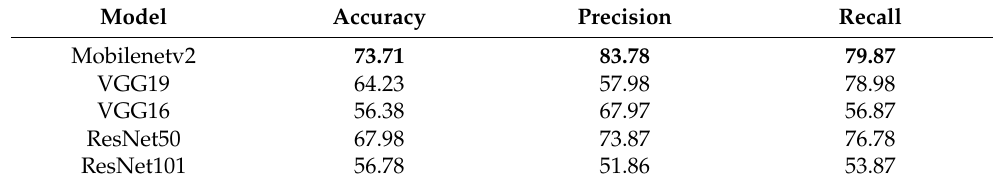
Table 4. Classification, precision, and recall (%) on enhanced dataset using power law transformation.